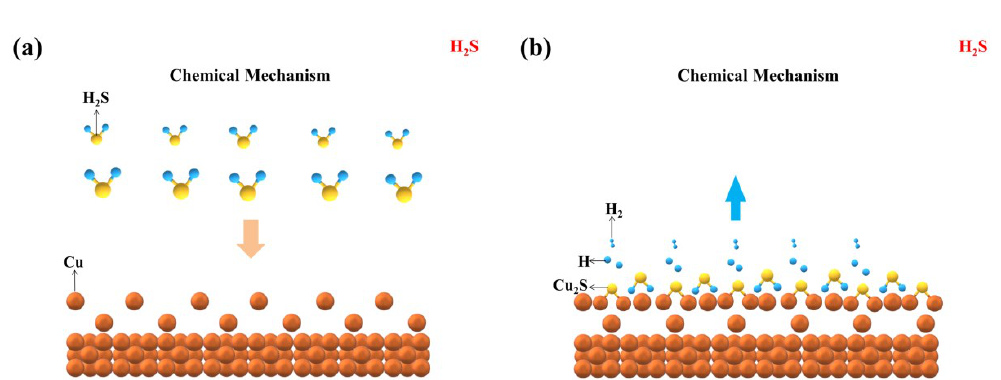
Figure 11. Schematic diagram of corrosion steps of copper sheet in H 2 S-containing LPG. ( a ) step1. ( b ) step2.